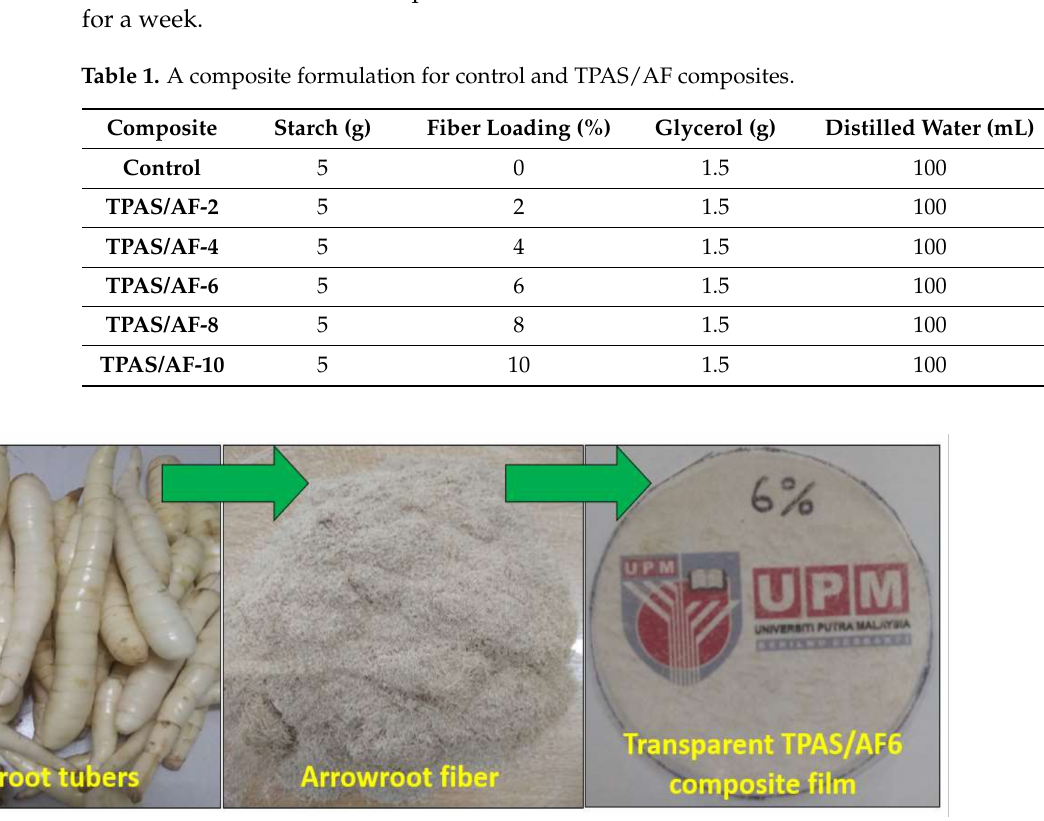
Figure 1. The arrowroot tubers, the fiber obtained from starch extraction, and transparent TPAS/AF composite film with 6% fiber